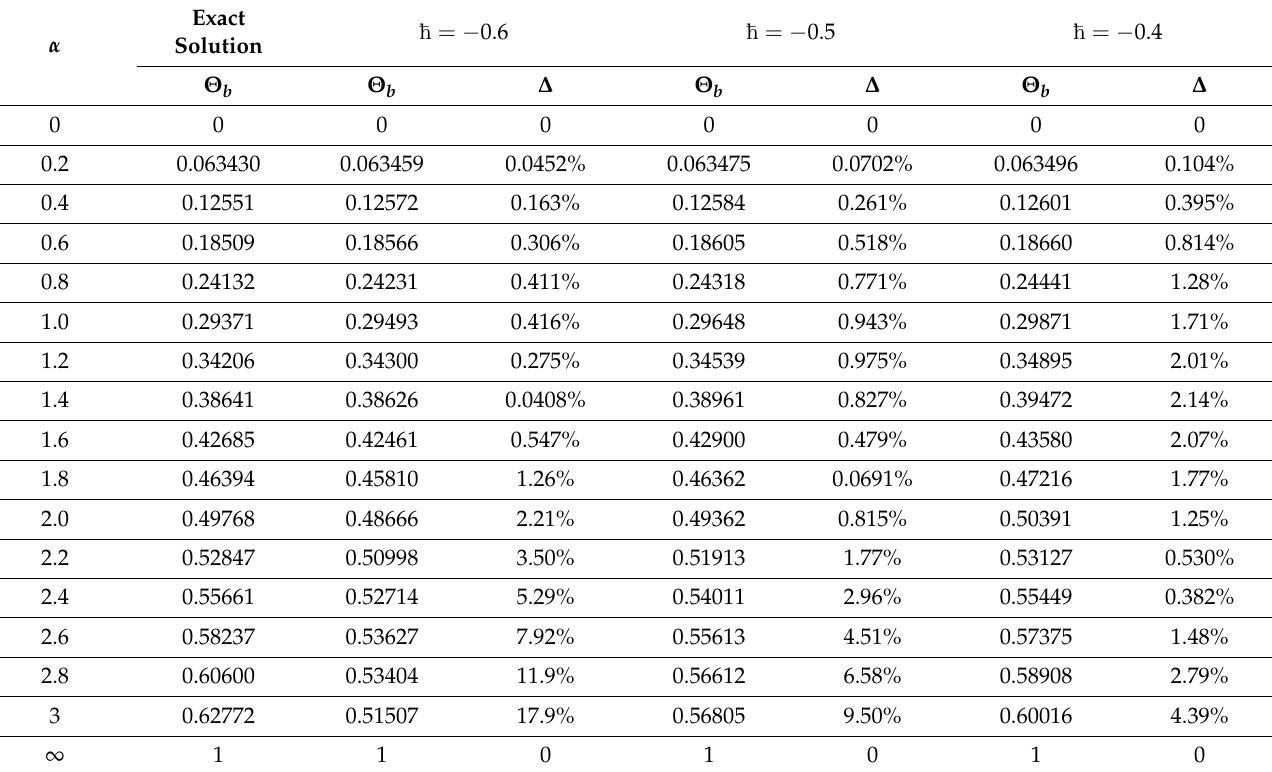
[ n = 3 ] by IHAM with different ћ and fixed ε = 8/ π 2 b